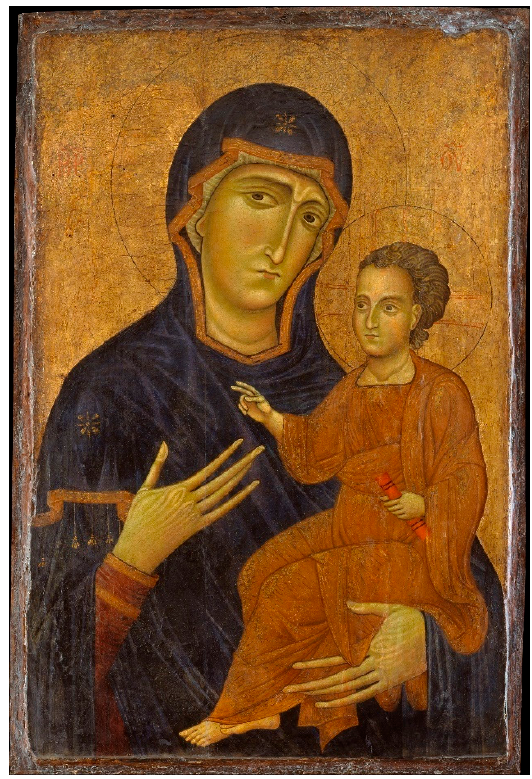
Figure 2. Berlinghiero Berlinghieri, Madonna and Child , ca. 1230s, New York, Metropolitan Museum of Art (image in the public domain).